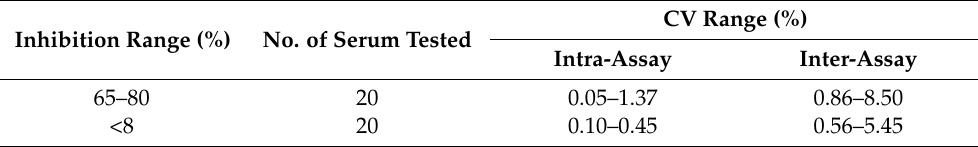
Table 1. Coefficient values of the samples tested by mAb1504-based cELSIA. Inhibition Range (%) No. of Serum